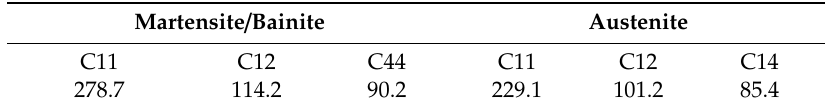
Table 3. Material model parameters (GPa).